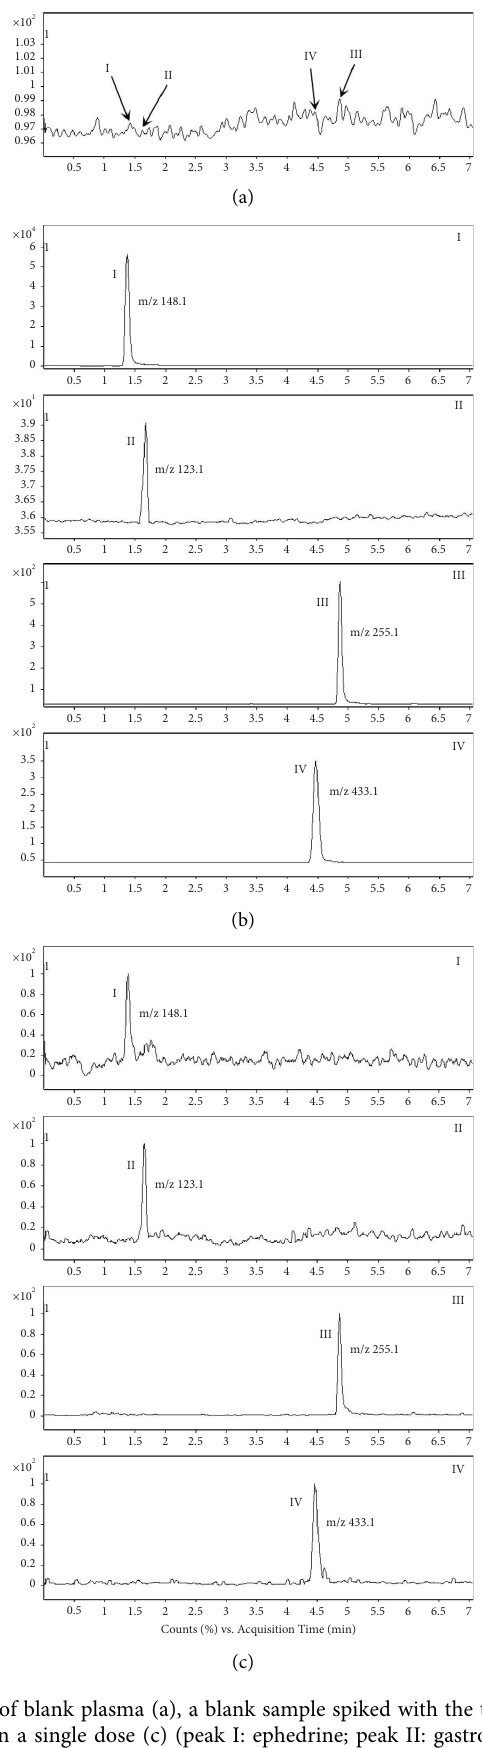
Figure 2: Typical MRM chromatograms of blank plasma (a), a blank sample spiked with the three compounds and I.S. (b), and plasma sample after intragastric administration in a single dose (c) (peak I: ephedrine; peak II: gastrodin; peak III: liquiritin; peak IV: